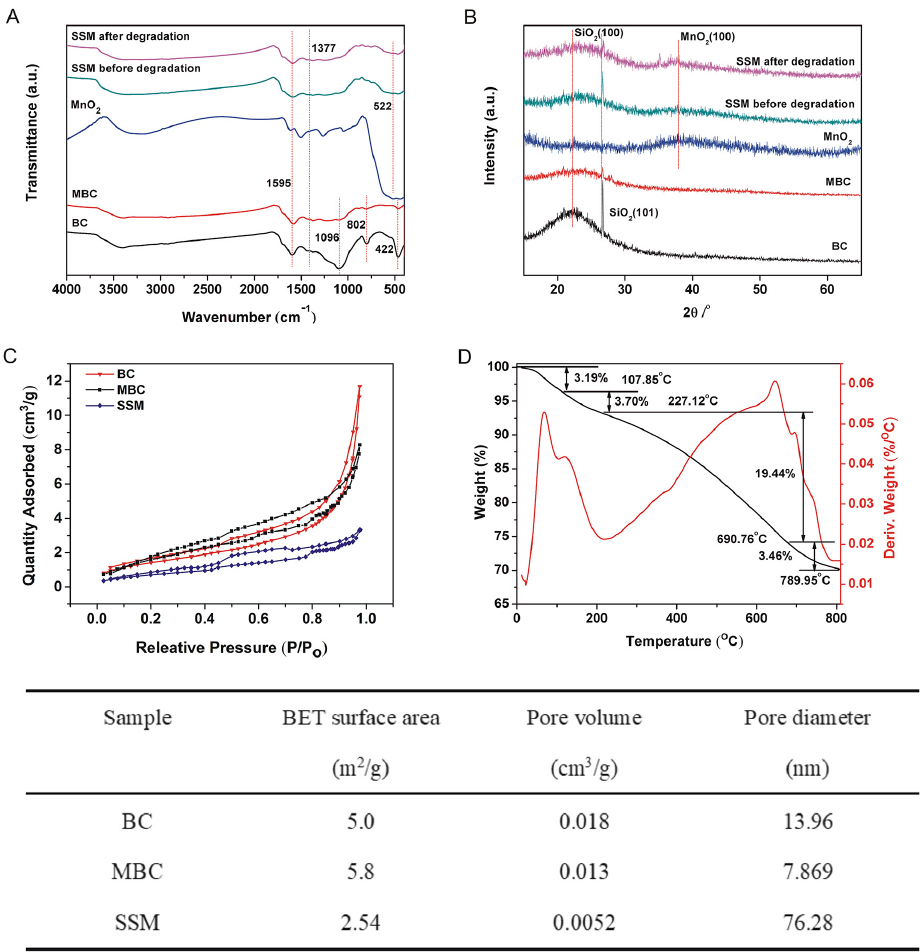
Figure 5. ( A ) FTIR spectra and ( B ) XRD spectra of BC, MBC, MnO 2 , and SSM before and after CTC degradation; ( C ) nitrogen adsorption − desorption isotherms of BC, MBC, and SSM; ( D ) TGA pattern of SSM. The table shows the BET results of BC, MBC, and SSM.